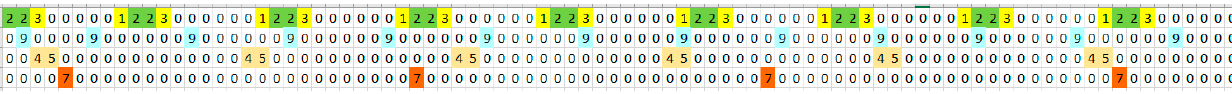
Figure 4. Data transfer used for a cycles-finding algorithm. Example: Cycles-finding algorithm.